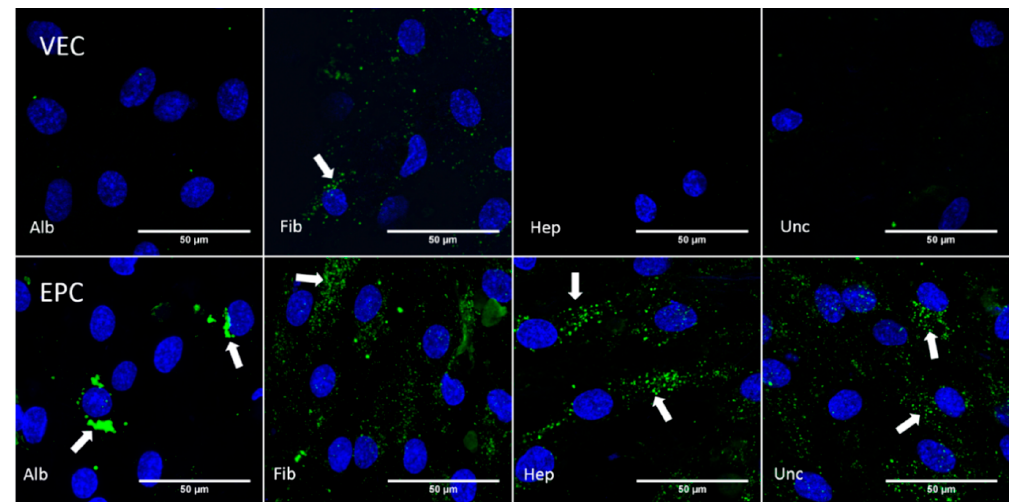
Figure 9. Confocal microscopy images from vascular endothelial cells (VEC) and endothelial progenitor cells (EPC) cultivated under static conditions on bacterial nanocellulose patches coated with albumin (Alb), fibronectin (Fib), heparin–chitosan (Hep) and on uncoated (Unc) patches. The cell nuclei were stained against DAPI (blue), and acetylated low density lipoprotein particles are shown in green (indicated by arrows). The VECs in the albumin and uncoated groups only showed nonspecific signals.